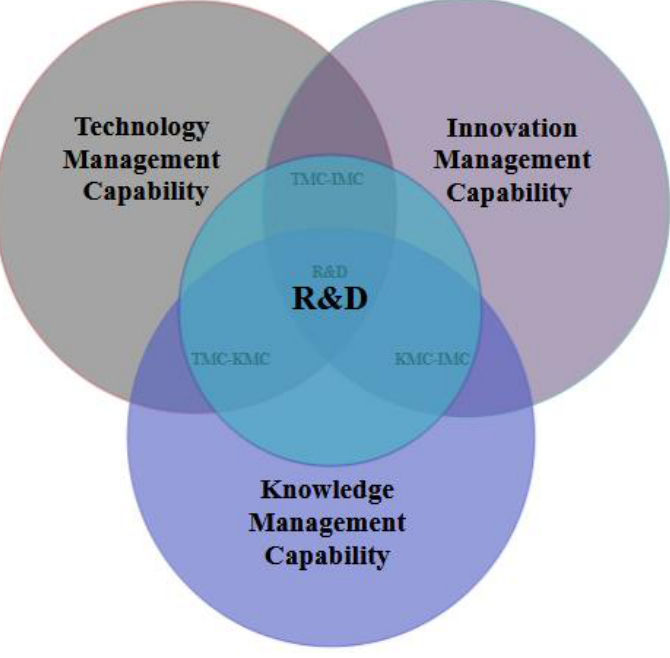
Figure 1. Frontiers between (KM), (IM), and (TM) within R&D. Sources: [15 – 17].